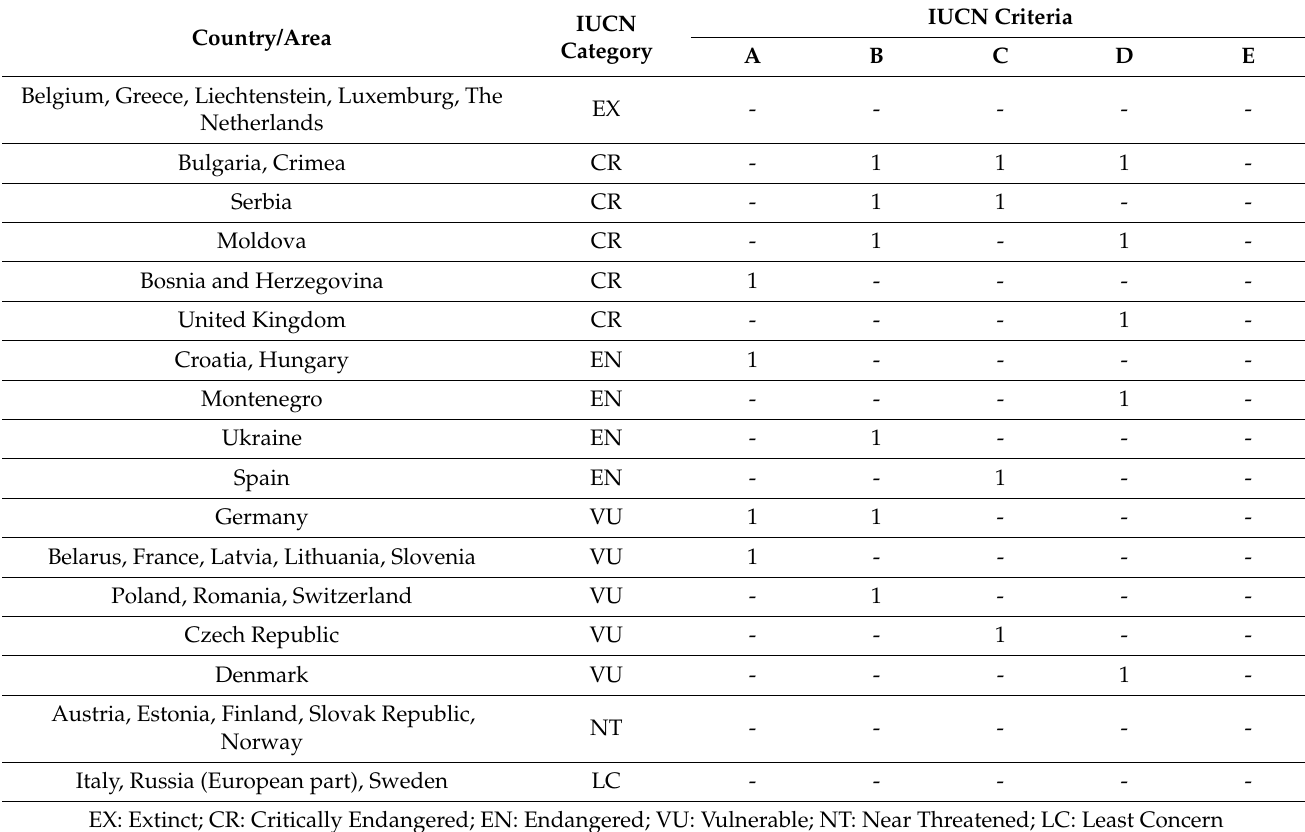
Table 1. Threat status in European countries, by International Union for Conservation of Nature (IUCN) categories.